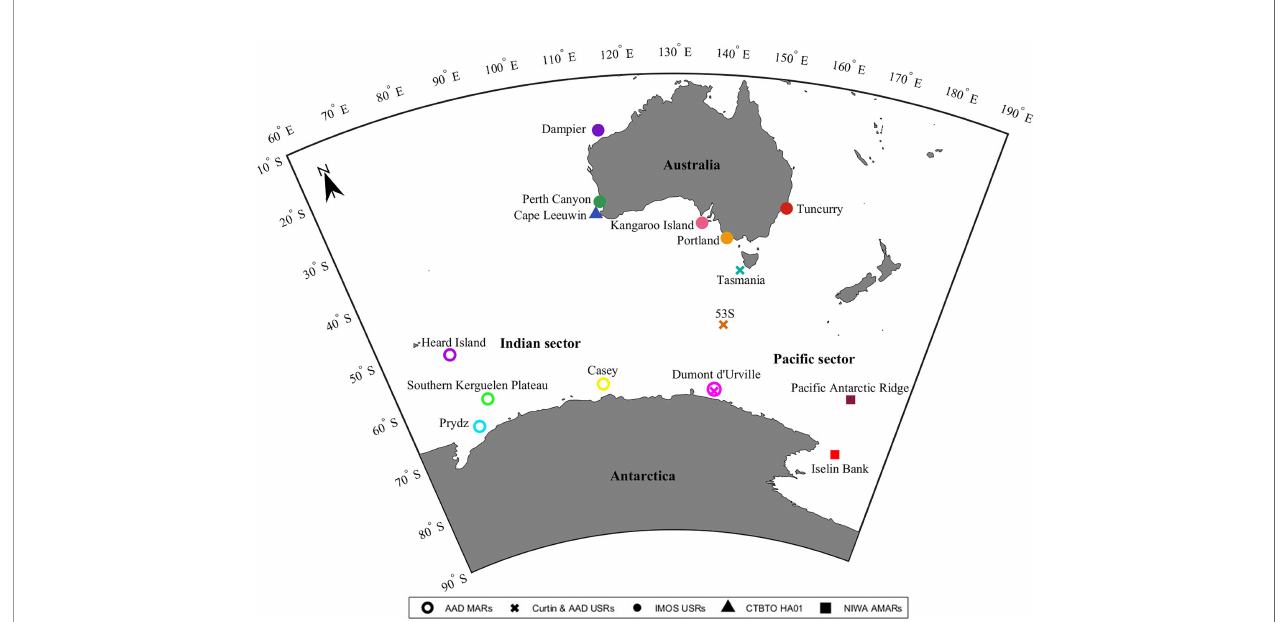
FIGURE 1 | Deployment locations of the passive acoustic monitoring systems used to obtain underwater sounds. Colours indicate sites. Circles indicate Moored Acoustic Recorders (MARs) of the Australian Antarctic Division (AAD). Crosses indicate Customised Underwater Sound Recorders (USRs) of Curtin University and the AAD. Dots indicate USRs of the Australian Integrated Marine Observing System (IMOS). Triangles indicate the hydroacoustic station (HA01) of the Comprehensive Test Ban Treaty Organisation (CTBTO). Squares indicate Autonomous Multichannel Acoustic Recorders (AMARs) of the New Zealand National Institute of Water and Atmospheric Research (NIWA). Equidistant Conic Projection